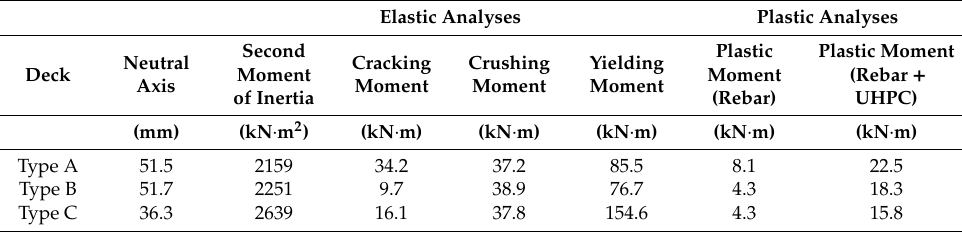
Table 4. Summary of sectional analyses.